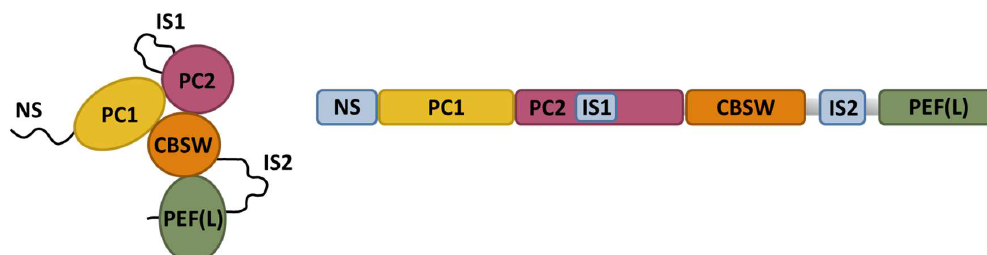
Figure 4. Schematic representation of CAPN3 structure. CAPN3 is comprised of two protease core domains (PC1 and PC2), a calpain-type β-sandwich domain (CBSW), and a penta E-F hand domain (PEF) that binds four calcium ions and may contribute to CAPN3 dimerization. The three specific regions of CAPN3 (NS, IS1, and IS2) are shown in blue. Schematics have been modified from Ye et al., 2018 [82]. The right panel depicts the estimated tertiary structure of CAPN3.